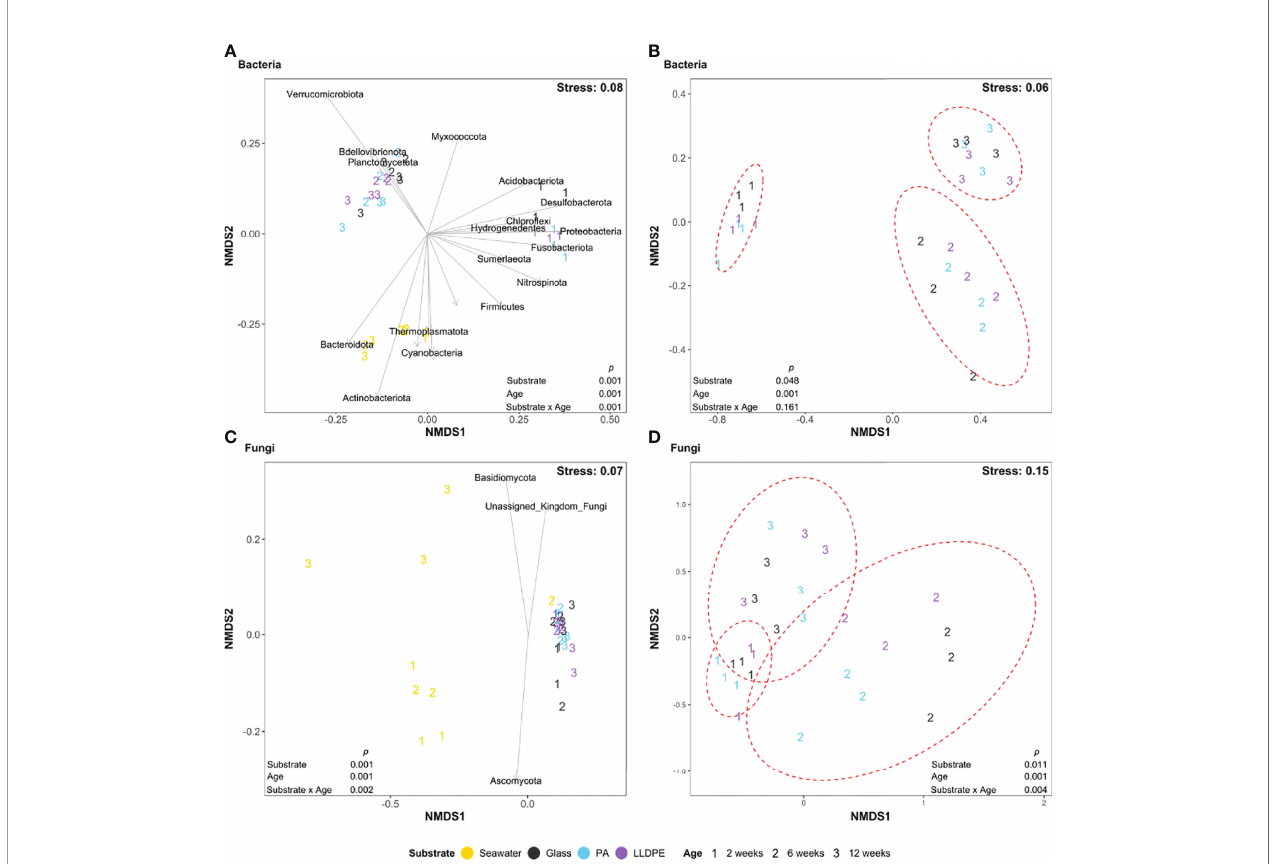
FIGURE 1 | Non-metric multidimensional scaling (NMDS) ordination for the visualisation of Bray-Curtis similarities of (A, B) bacterial (C, D) fungal communities in the surrounding seawater and on glass, nylon-6 (PA) or linear low-density polyethylene (LLDPE) in the marine environment of Te Whakaraup ō -Lyttelton Harbour, Aotearoa-New Zealand, labelled according to substrate type and bio fi lm age. Closer proximity of points indicates increasing compositional similarity among those data. PERMANOVA results are shown as p values, assessing the impact of the substrate type, bio fi lm age and their interaction. Black arrows represent signi fi cant (P < 0.05) phyla correlating with ordination of samples. Ellipses were drawn using the stat_ellipse function of ggplot2 assuming a multivariate t-distribution and represent variance observed among each different sample age with 95% con fi dence